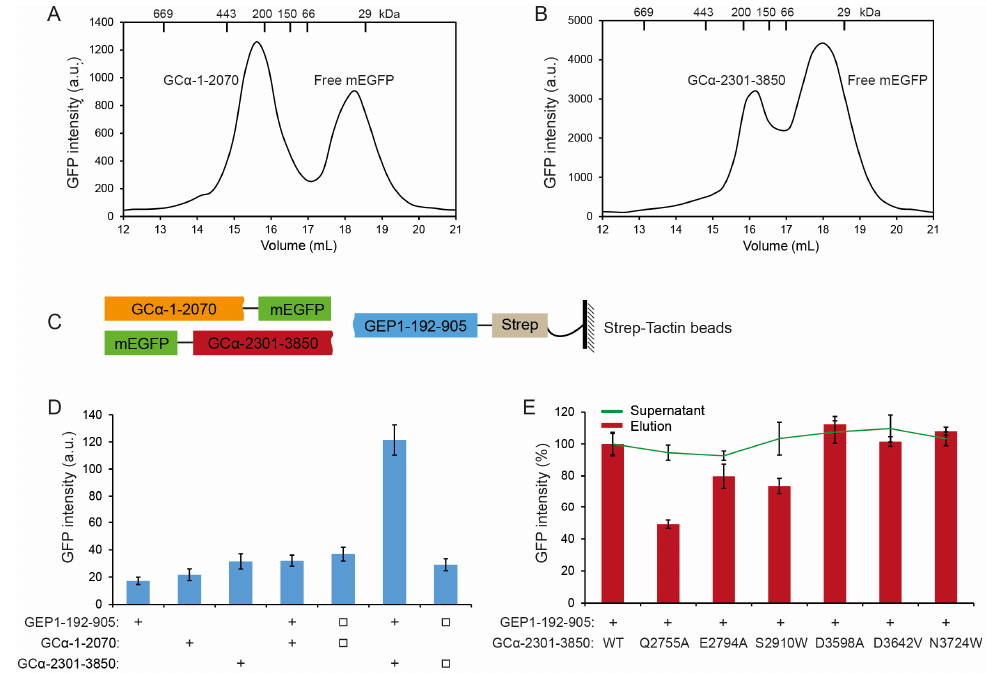
Figure 5. Expression of guanylate cyclase α (GC α ) and its interaction with GEP1 192-905 . ( A , B ) FSEC profiles of GC α 1-2070 with C-terminal mEGFP and GC α 2301-3850 with N-terminal mEGFP. Samples were run on a Superose 6 Increase 10/300 GL column using buffer (5 mM HEPES pH 7.6, 150 mM NaCl, 0.03% DDM, 2 mM β -ME). GFP intensity was detected by a microplate reader (excitation 485 nm, emission 528 nm). ( C ) Schematic diagram for probing GEP1-GC α interaction. ( D ) mEGFP tagged N-terminal half (GC α 1-2070 ) and C-terminal half (GC α 2301-3850 ) were used for a pull-down assay with Strep-tagged GEP1 192-905 using Strep-Tactin beads. ‘+’ indicates co-expression, and ‘ □ ’ indicates co- purification of proteins expressed separately. ( E ) Mutations on GC α 2301-3850 were used for a pull- down assay with Strep-tagged GEP1 192-905 using Strep-Tactin beads. A green line shows the GFP intensity in the supernatant, indicating the expression level for each mutant.